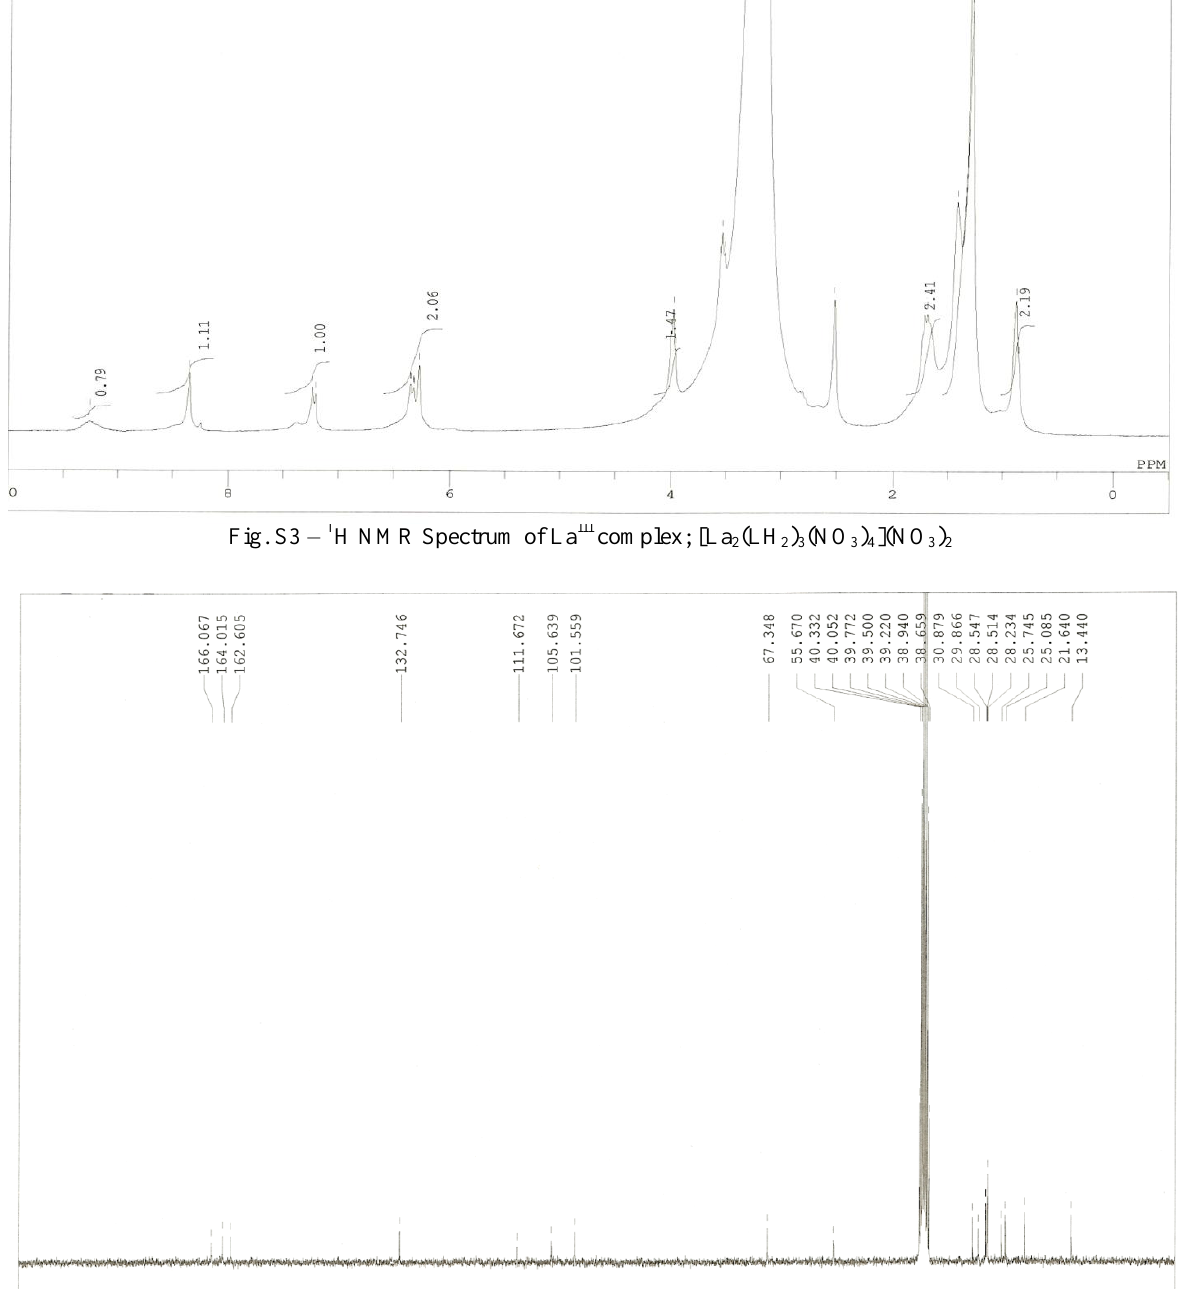
Fig. S4 – 13 C{ 1 H} NMR Spectrum of La III complex; [La